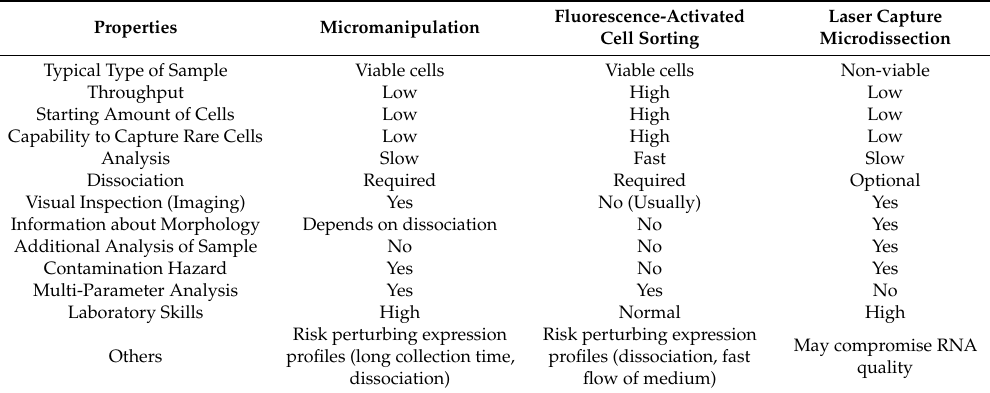
Table 1. Comparison of traditional approaches for single-cell